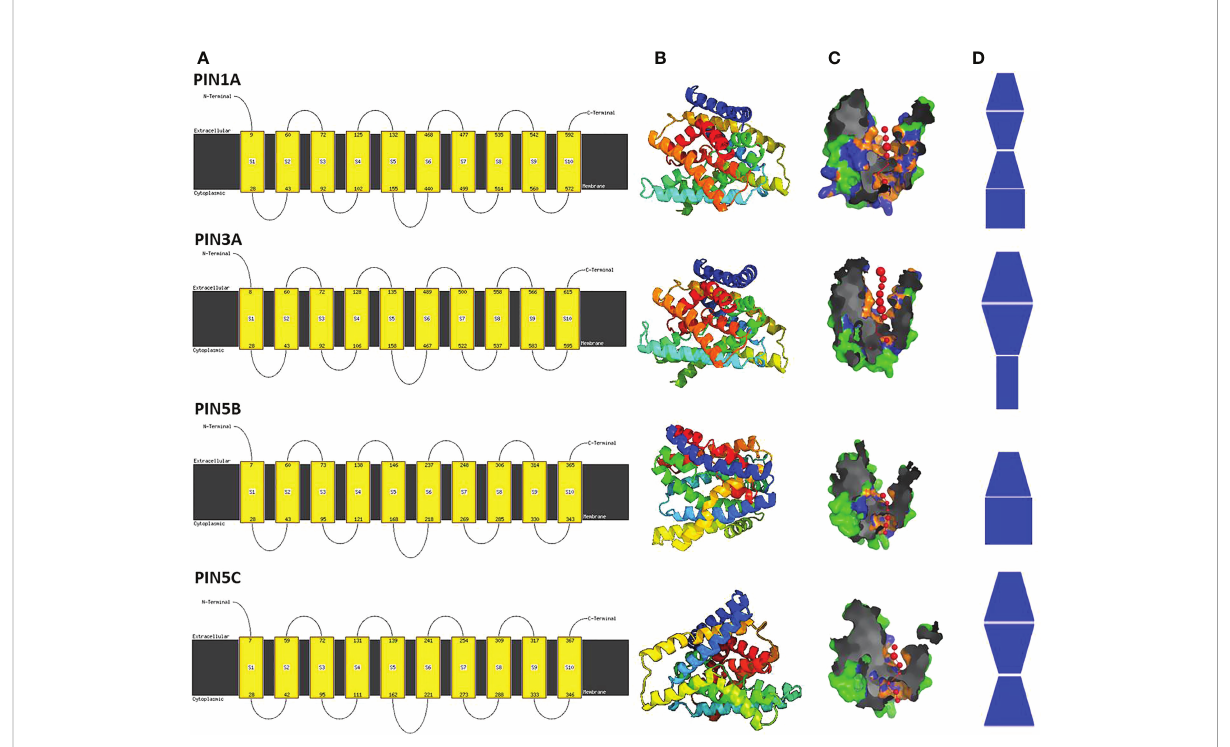
FIGURE 3 Predicted three-dimensional (3D) models of four rice PIN proteins. (A) The cell membrane organization of PIN proteins indicates 10 transmembrane domains and one larger hydrophilic loop (HL) domain present between HL domains 5 and 6. (B) The predicted 3D protein structure of PIN proteins indicates the presence of 10 a helices that constitute 10 transmembrane domains. (C) Pore morphology of the PIN proteins. (D) Pore shapes of PIN proteins indicate varying pore dimensions and